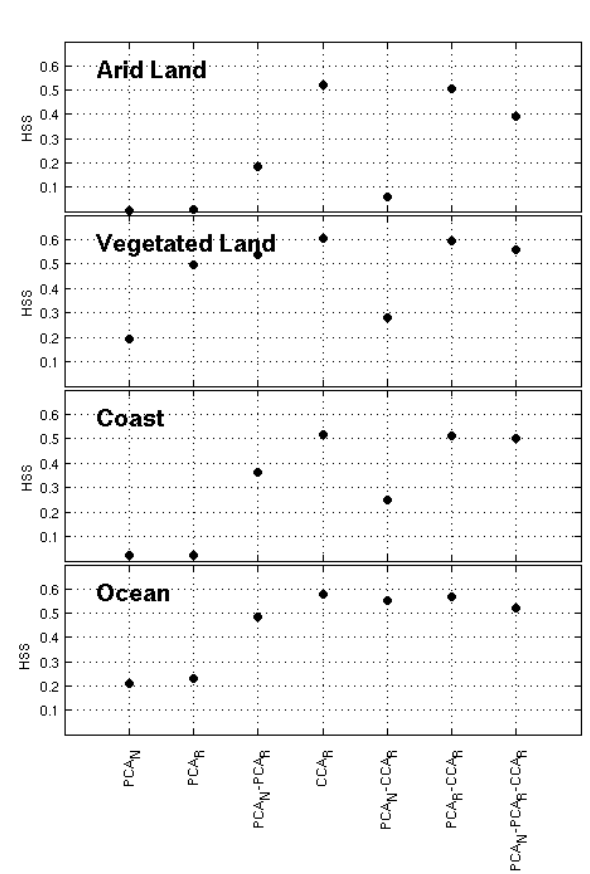
Figure 2. Results of the choice of the discriminant function over dif- ferent background surface for the SSMIS data set: the labels of the x axis identify the discriminant function used (see text for details) and the value represented in the y axis is the Heidke skill